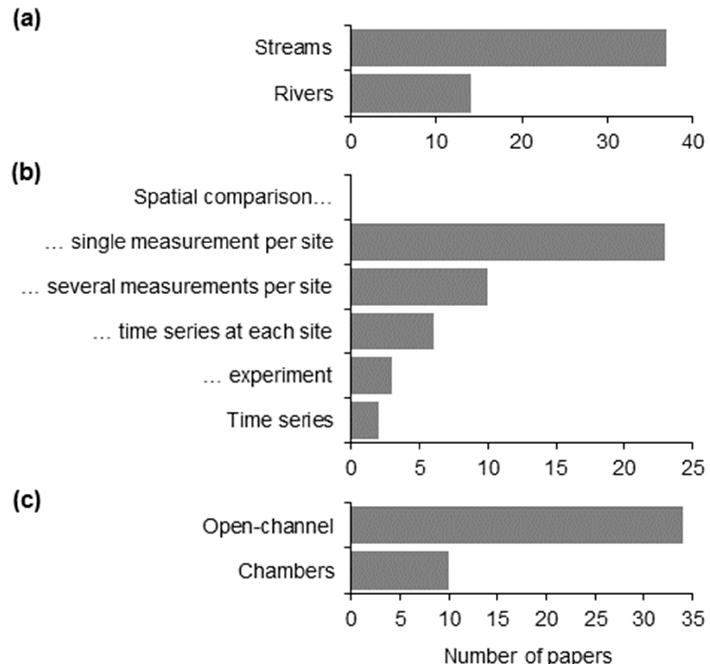
Figure 9. Representation of the ( a ) lotic systems, ( b ) methodological approaches, and ( c ) general methods used in field studies addressing ecosystem metabolism as a bioassessment tool ( n = 44). Several studies were carried out in both streams and rivers and so the sum of the studies across systems surpasses the number of field studies.